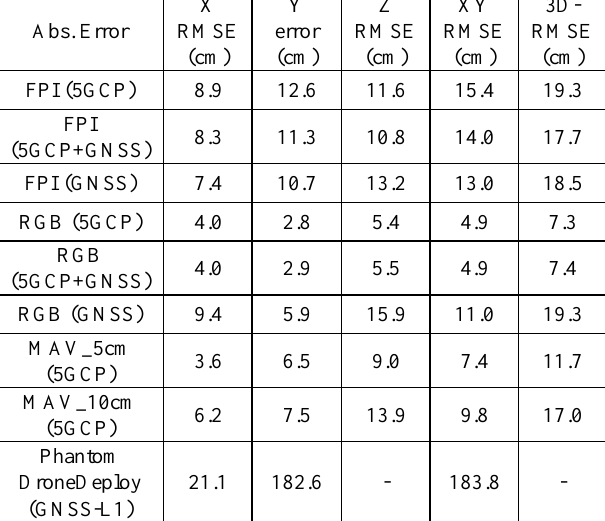
Table 2. RMSE values of coordinates, based on 27 check points, for different georeferencing options.